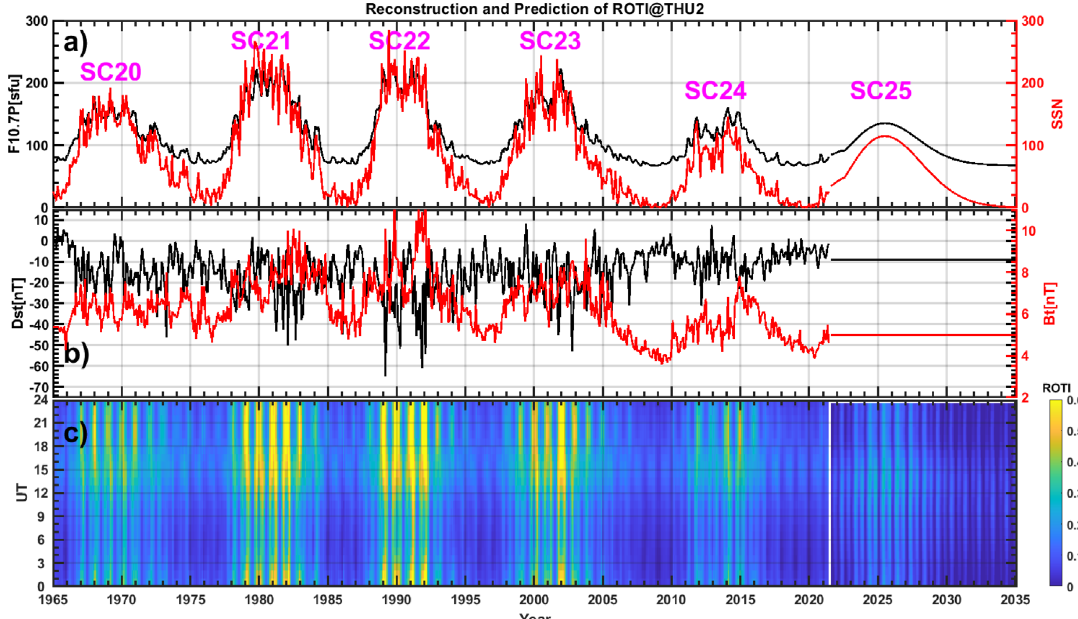
Fig. 10. (a) The monthly averaged F10.7P index (black), sunspot number (red). (b) The monthly averaged Dst index (black) and magnetic strength of IMF (red). (c) The reconstructed ROTI climatology in bins of 1 hour in UT by 1 month from 1965 to 2035. The predicted values of F10.7P and sunspot number are plotted from August 2021 to 2035. One month (July 2021) is intentionally omitted to separate observations and predictions.